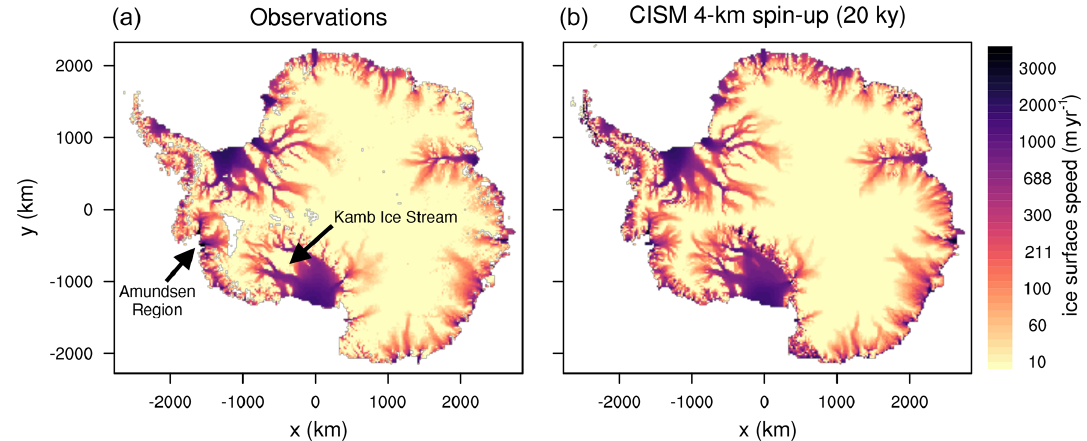
Figure 1. Observed (Rignot et al., 2011) (a) and modeled (b) Antarctic surface speed (myr − 1 , log scale) for the initial spin-up state used to initialize our 25 ensemble spin-ups (using p = 0 and γ 0 = 2062539). The root mean square error between observed and modeled velocity is 128.7myr − 1 . White patches represent missing data.